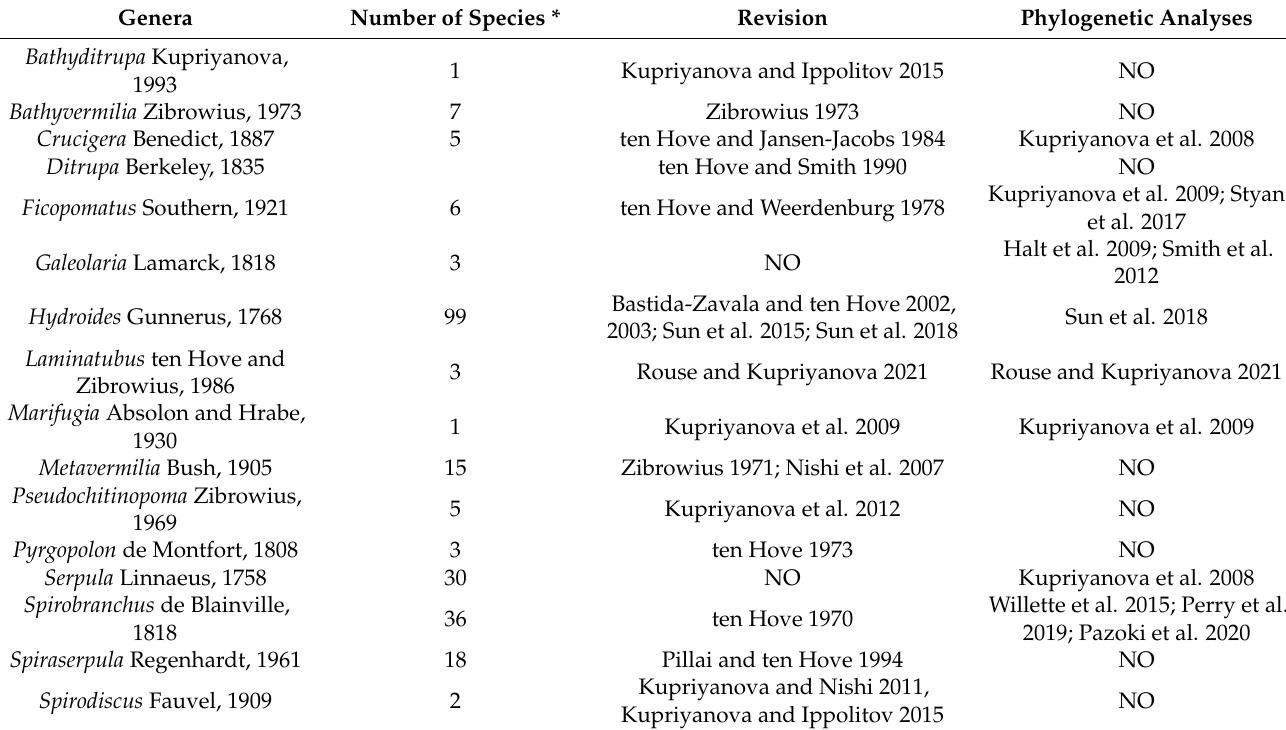
Table 4. Serpulid currently accepted genera that have undergone major or partial revisions and phylogenetic analyses (using morphological features, molecular data or